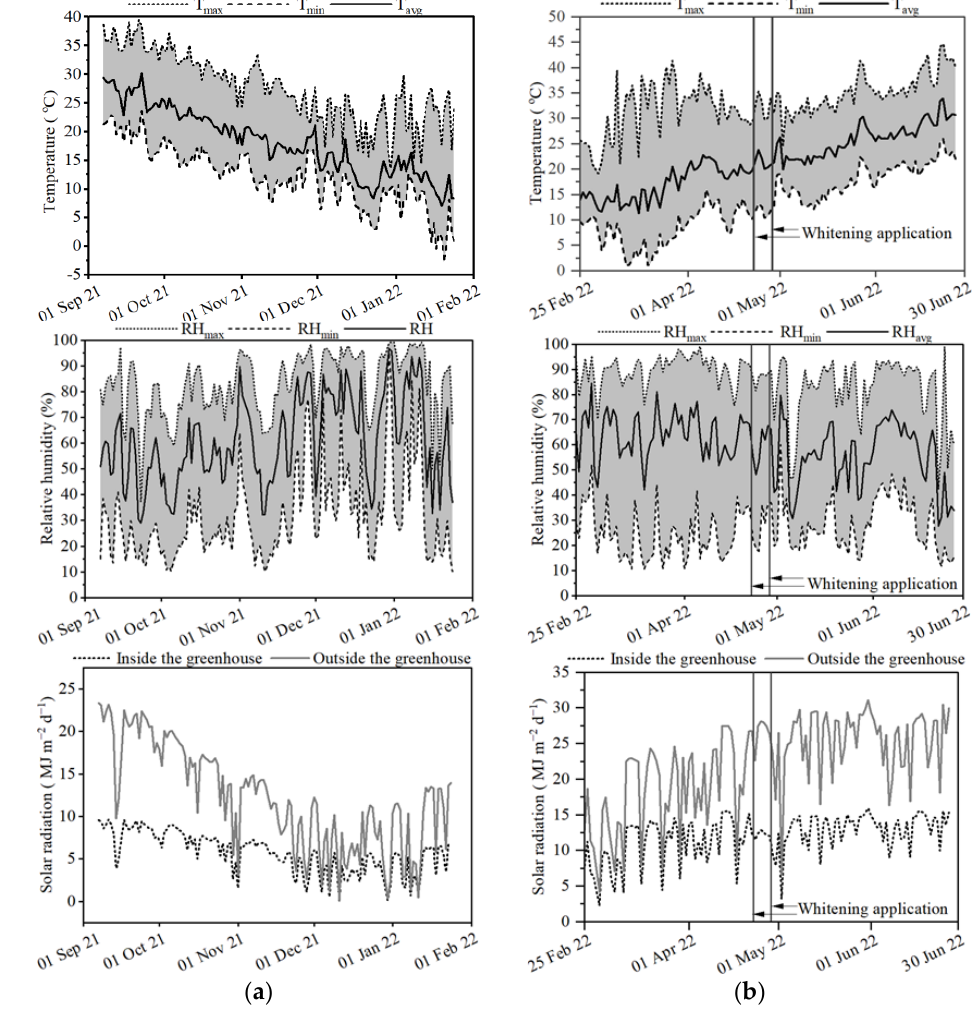
Figure 1. Daily variation of inside and outside temperature, humidity, and solar radiation throughout the growing seasons; ( a ) autumn 2021 and ( b ) spring 2022. Table 1. The effect of irrigation water salinity and sampling time on soil salinity throughout the growing seasons (autumn 2021 and spring